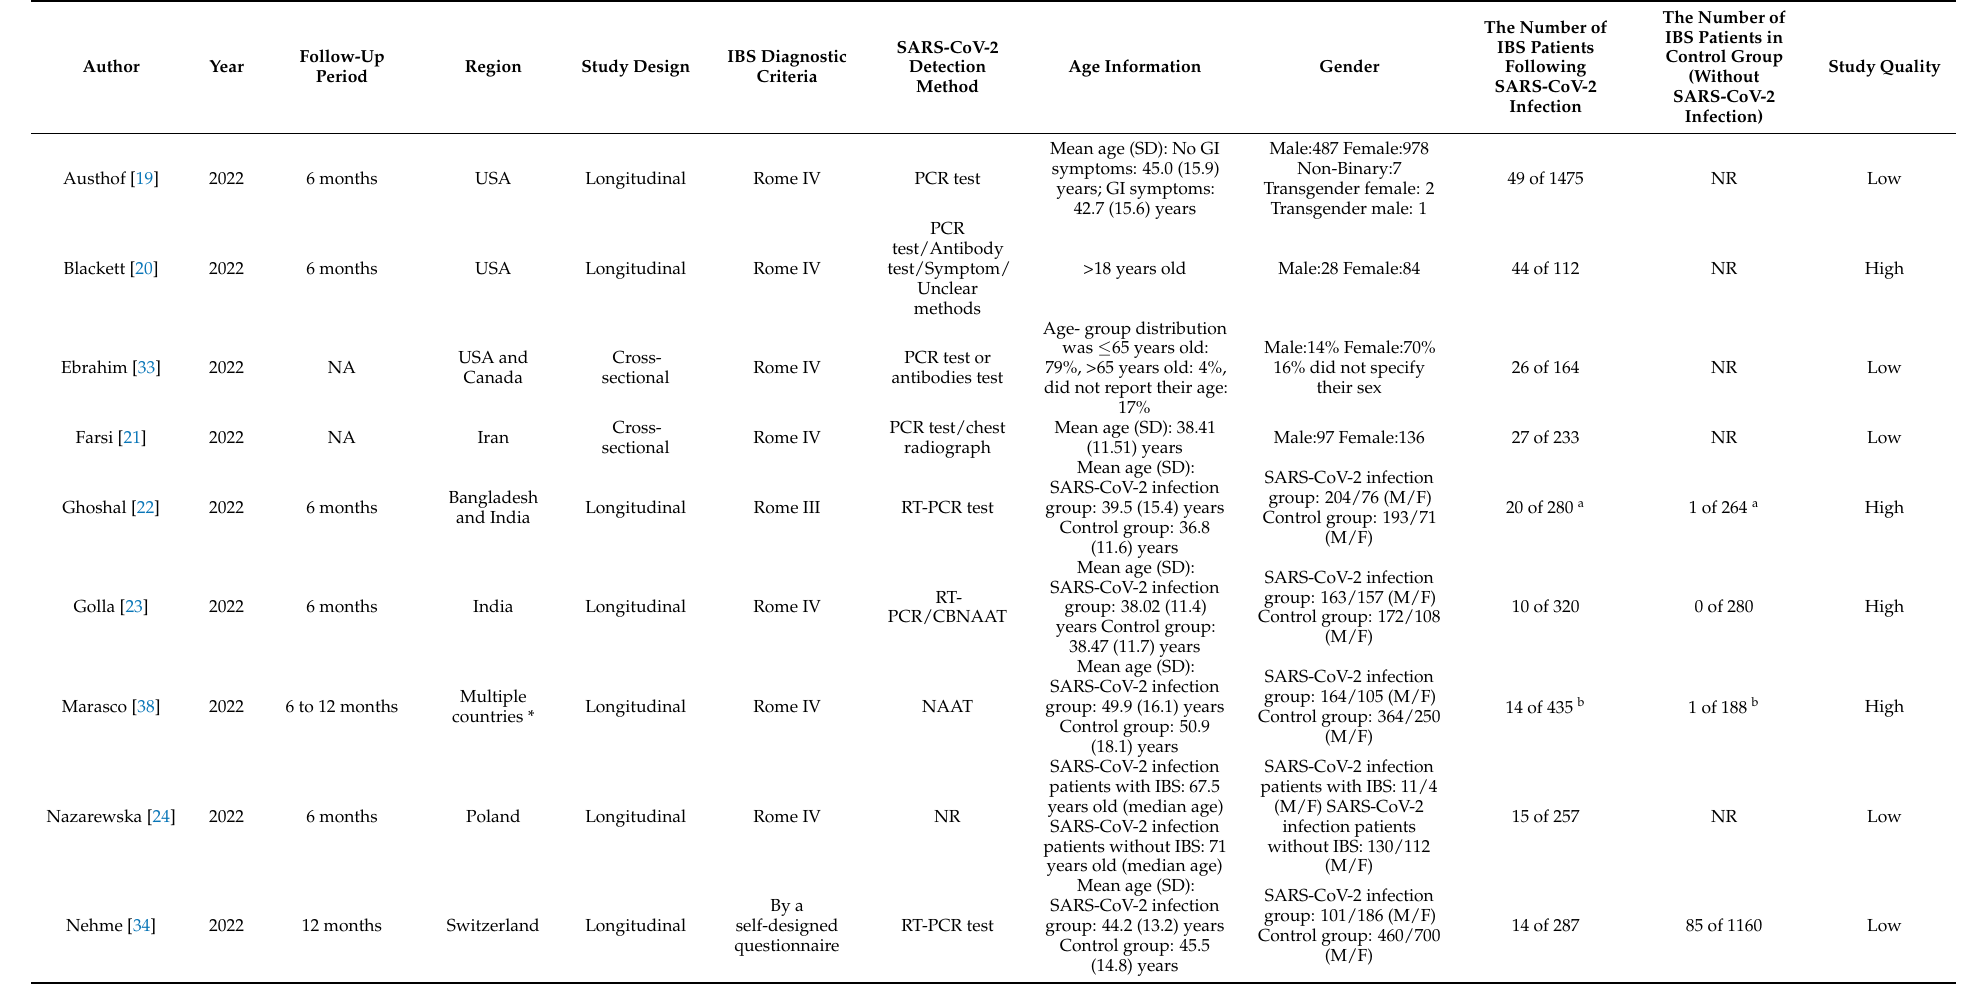
Table 1. The characteristics of the included